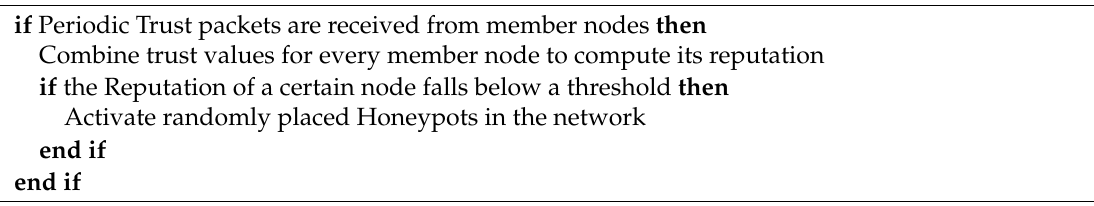
Algorithm 2 Reputation Management in RPL for Randomly placed